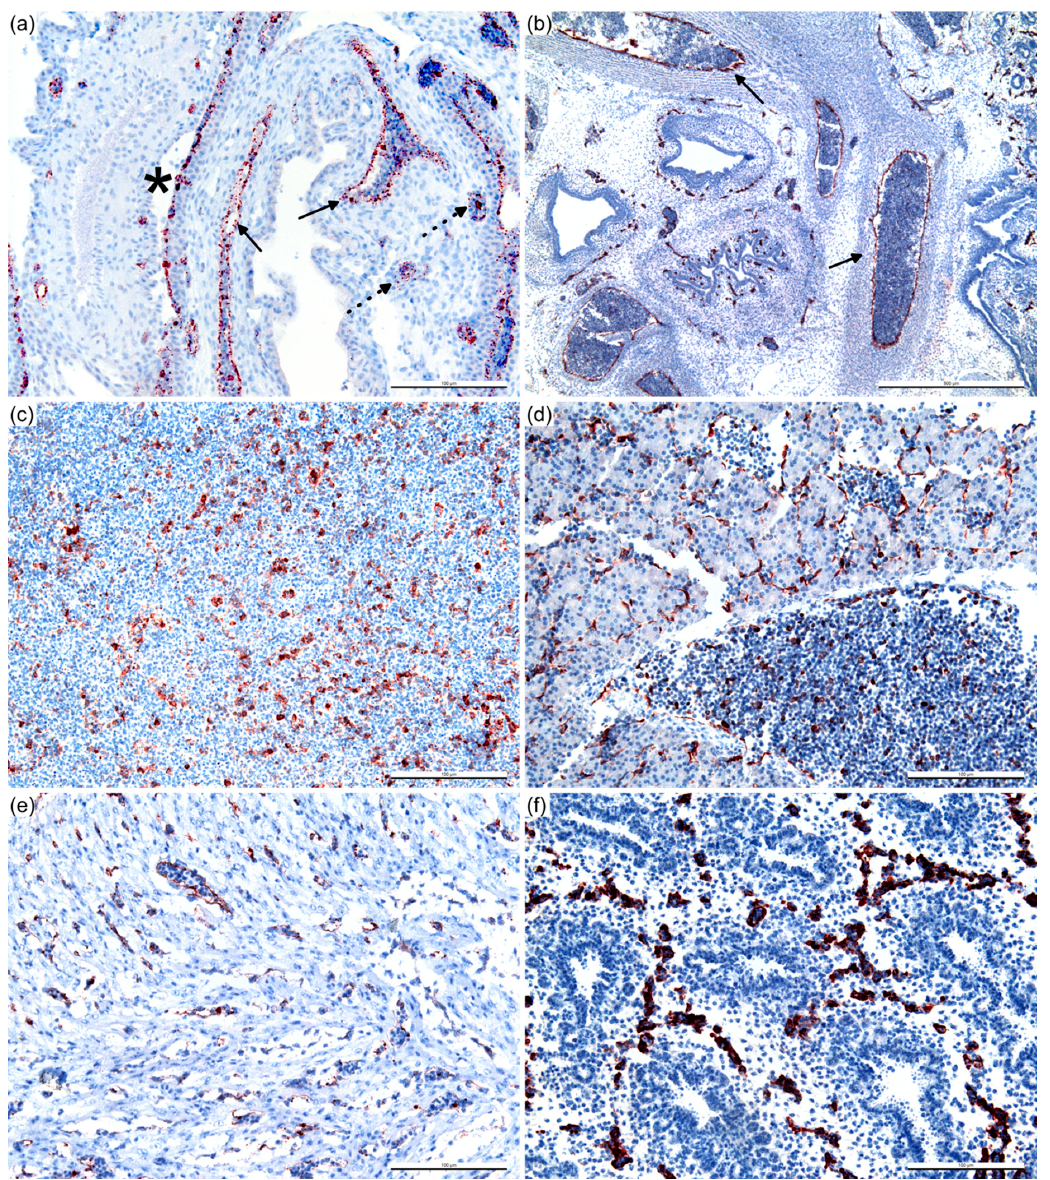
Figure 5. BTV non-structural protein 2 (NS2) antigens in infected chicken embryo at 3 DPI. Immuno-positive staining (red/brown color) in the chorionic epithelium (asterisk) and macro- (arrow) and microvascular (dashed arrow) endothelial cells of the chorioallantoic membrane ( a ), endothelium of the aorta and vena cava (arrow) ( b ), splenic cells ( c ), liver (endothelium of the central vein and sinusoidal endothelium, and hematopoietic cells) ( d ), and microvasculature of the heart ( e ) and lung ( f ). Immunohistochemistry, with hematoxylin counterstain. Scale bar = 500 μ m ( b ), 100 μ m ( a , c – f ).